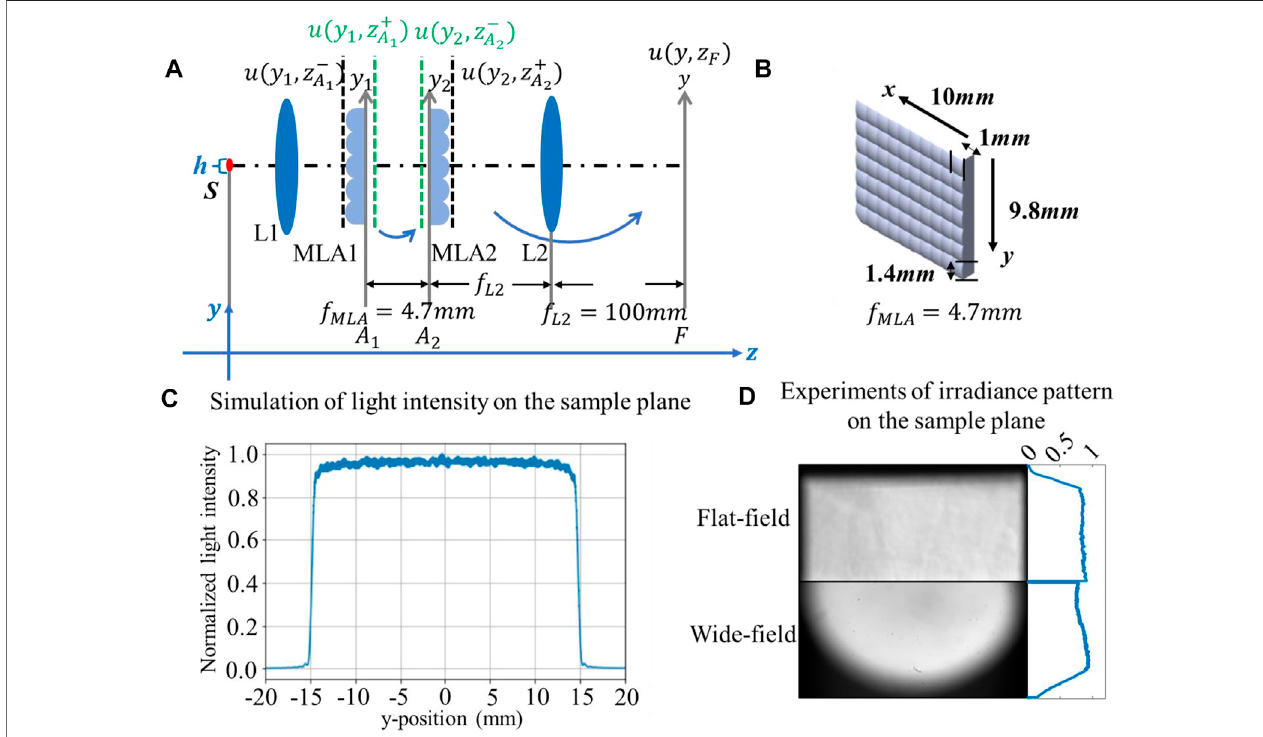
FIGURE2|(A) Model ofthebeam shaping module; (B) physical sizeoftheMLAs; (C) simulation result oflightintensity onthesampleplane; (D) comparison ofthe irradiance distribution on the sample plane between fl at- fi eld and wide- fi eld in the